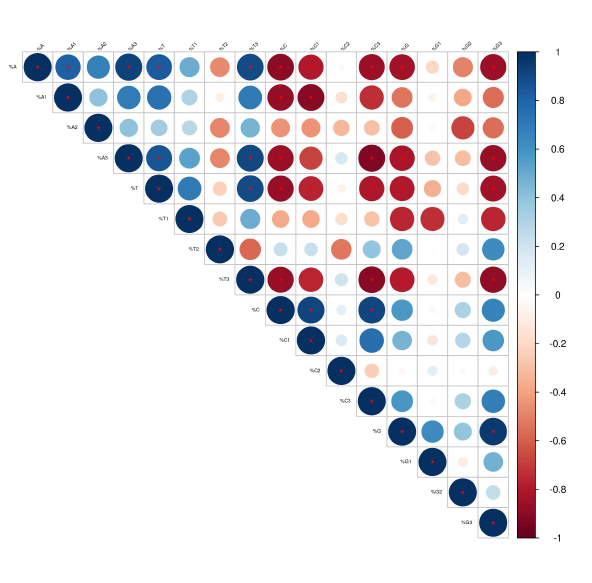
Fig. 2. Mirror plot showing the correlation between various nu- cleotidecompositionalconstraints. Rectangularboxesshowasignificant relationship. Blue boxes show a significant positive correlation; red boxes show a significant negative correlation. Empty spaces are indicative of the insignificant correlation.